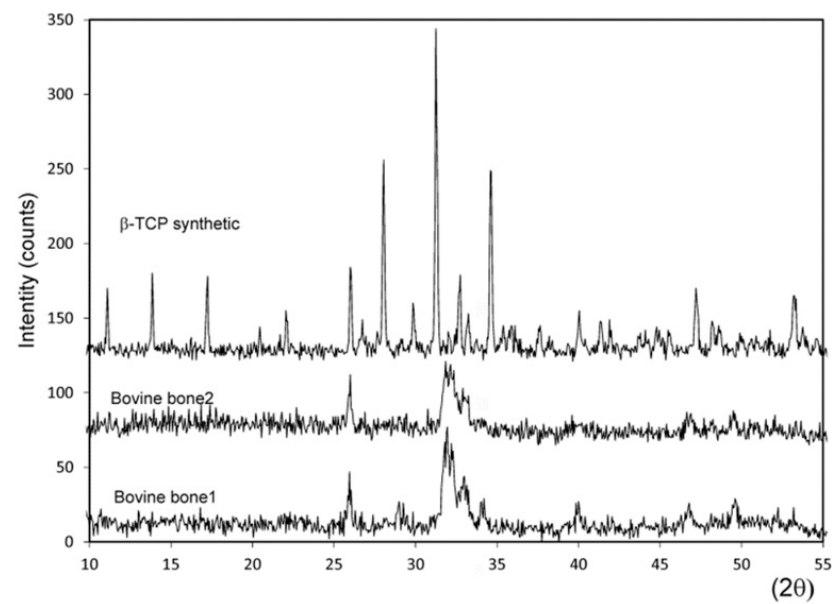
Figure 4. X-ray diffraction (XRD) of the synthetic TCP, bovine bone 1, and bovine bone 2.